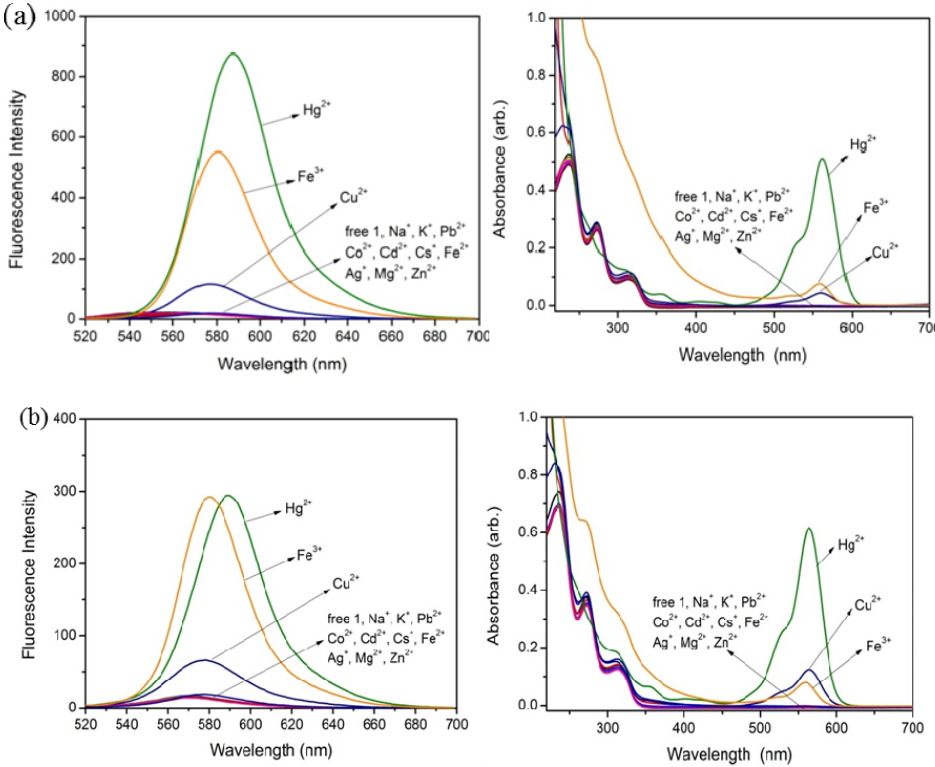
Figure 1. Fluorescence (left) and absorption (right) spectra of 1 ( a ) and 2 ( b ) (5 μ M) in CH CN/H O (3/1, v / v ) with different metal ions (400 μ M), 3 2